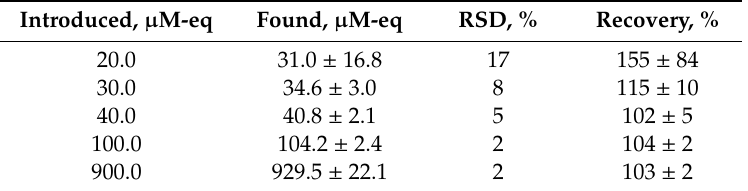
Table 2. AOA of L-ascorbic acid model solutions (n = 4, α = 0.05).